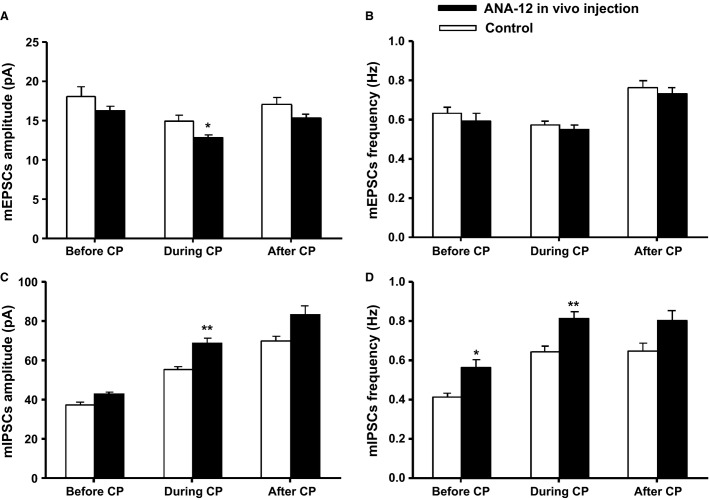
In vivo application of ANA-12 induced changes in mEPSCs and mIPSCs in HMs. Mean amplitude (in pA) (A) and frequency (in Hz) (B) of mEPSCs before, during, and after the critical period of control and ANA-12 injected rats are shown. Although all ages exhibited a decreasing trend in both amplitude and frequency of mEPSCs, only the amplitude at P12 had a significant decrease (*P < 0.05). On the other hand, ANA-12 effectively increased both the amplitude (C) and frequency (D) of mIPSCs during the critical period, and increased the frequency before the critical period (*P < 0.05, **P < 0.01).